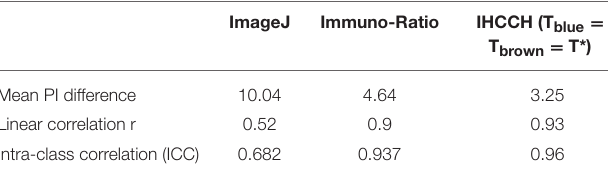
TABLE 1 | Performance comparison to similar